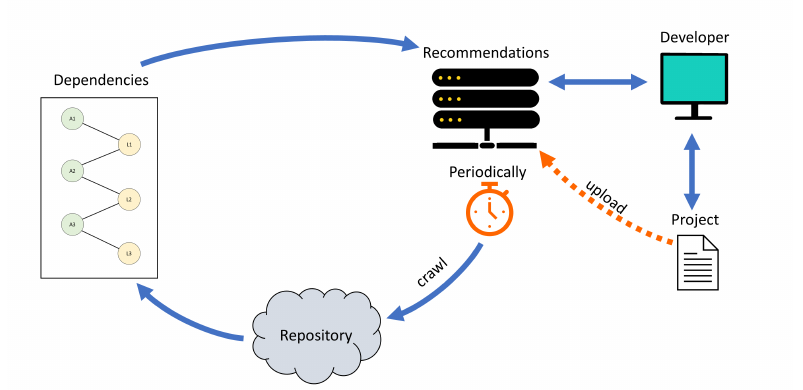
Figure 2. Recommendation pipelines based on no-learning graph inference. Periodic crawling only helps improve the quality of recommendations, and given that projects using similar libraries have already been crawled from code repositories, does not delay the